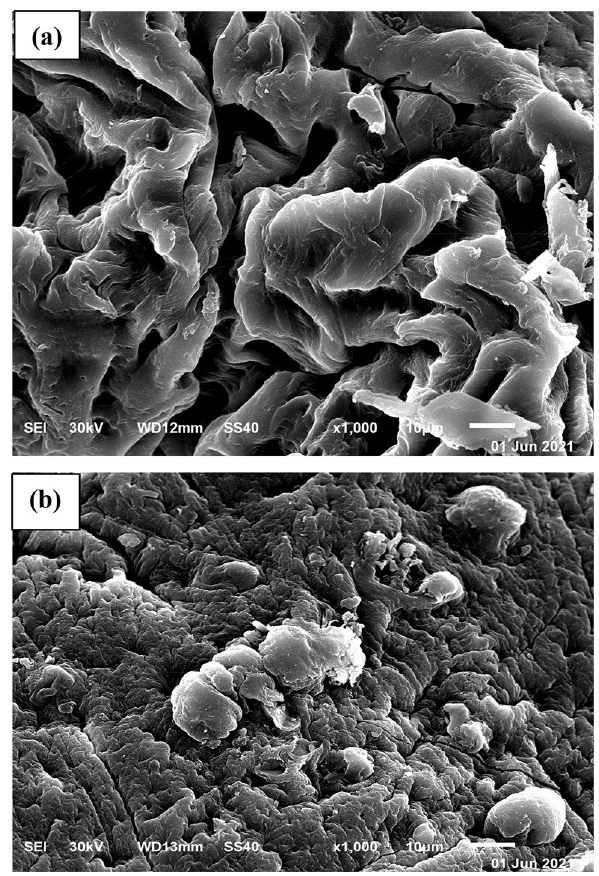
Figure 6. SEM images of R. damascena leaves ( a ) before and ( b ) after Cd 2+